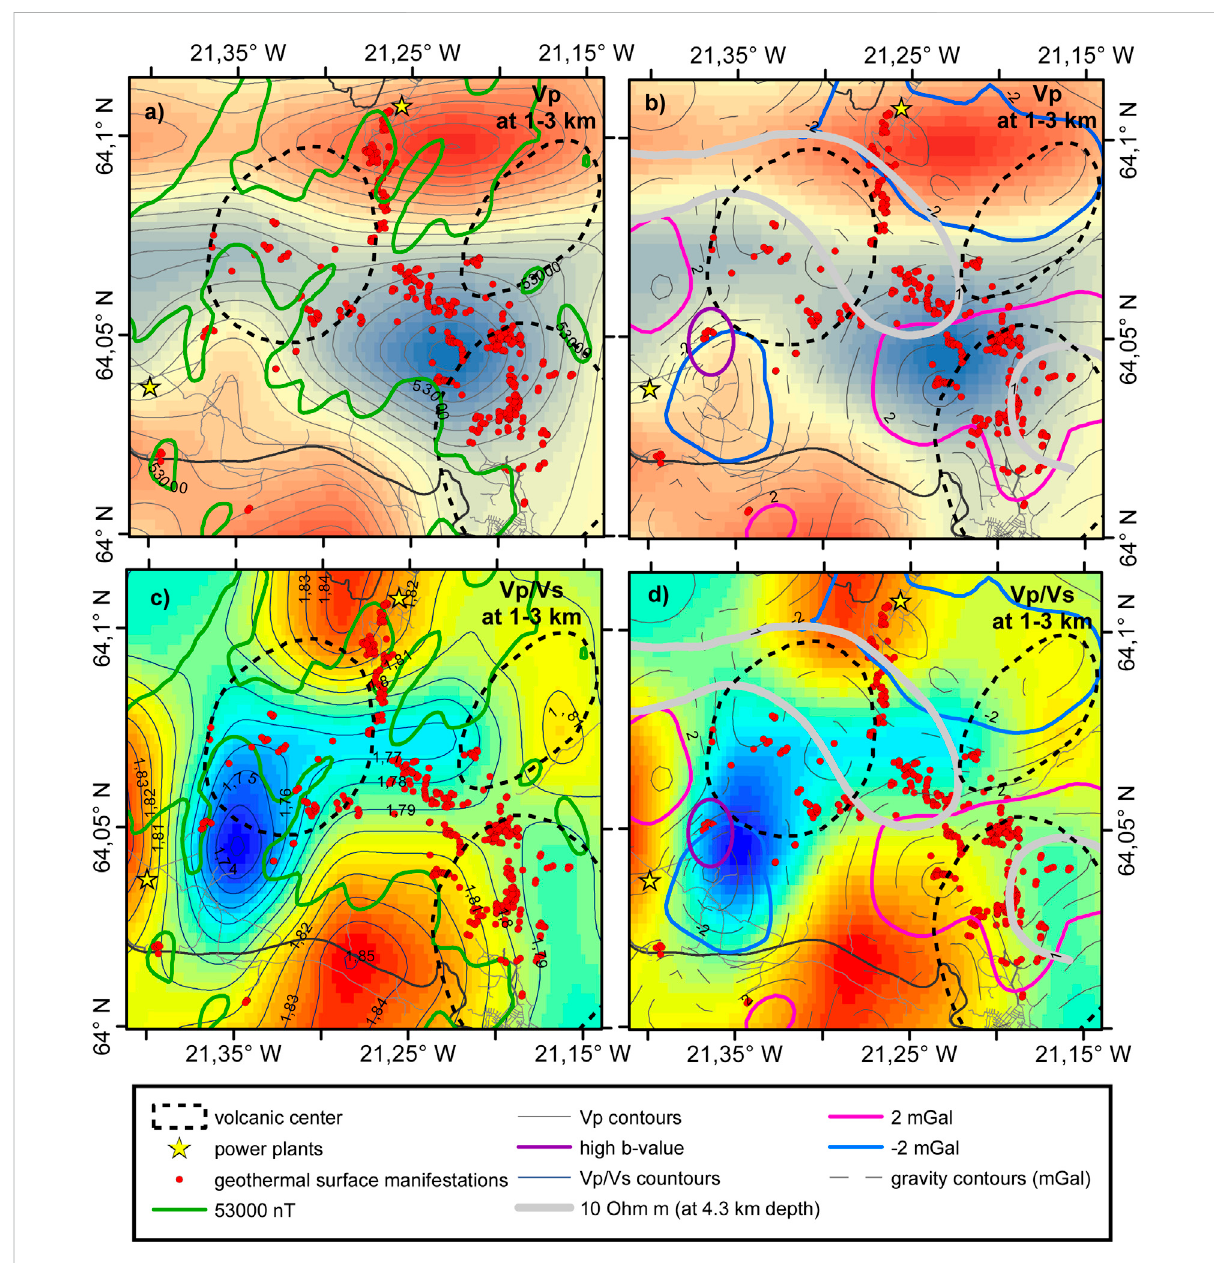
FIGURE 9 Comparison oftheVp (upper rows)and Vp/Vs (lower rows)modelat2 kmdepth withother geoscienti fi cresearchfrom theHengill geothermal areas and surroundings. Fumaroles (red dots) and volcanic centers (black broken lines), as well as the power plants (yellow stars) are drawn for orientation in all sub fi gures. On the velocity models we overlay: (A) Vp contour lines. (C) Vp/Vs contour lines. (A,C) aero-magnetic low ( < 53.000 gamma) shown as green thick lines (Björnsson and Hersir, 1981; Hersir et al., 1990). (B,D) a resistivity low ( < 10 Ω m) at 4.3 km depth as white thick lines (Árnason et al., 2010)and residual Bouguer gravity with pink lines encircling gravity high and blue gravity low; Björnsson et al., 1986; Hersir et al., 1990). The area in Sleggja with a high b-value is outlined by the purple